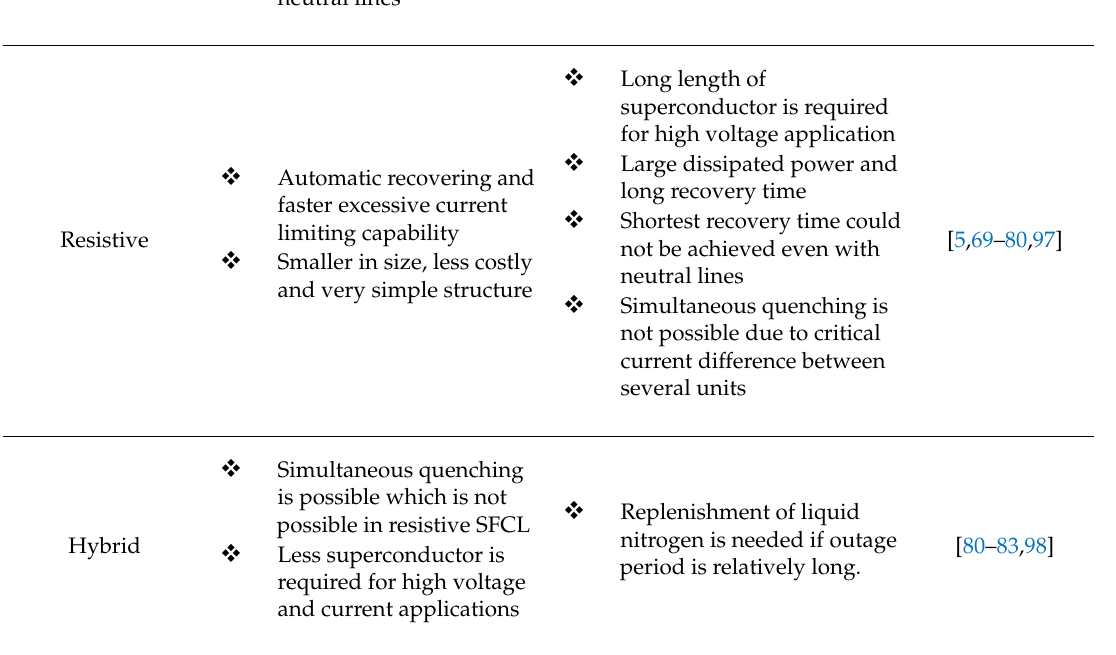
Figure 4. The phases for implementing a N-AHP in SWOT analysis.